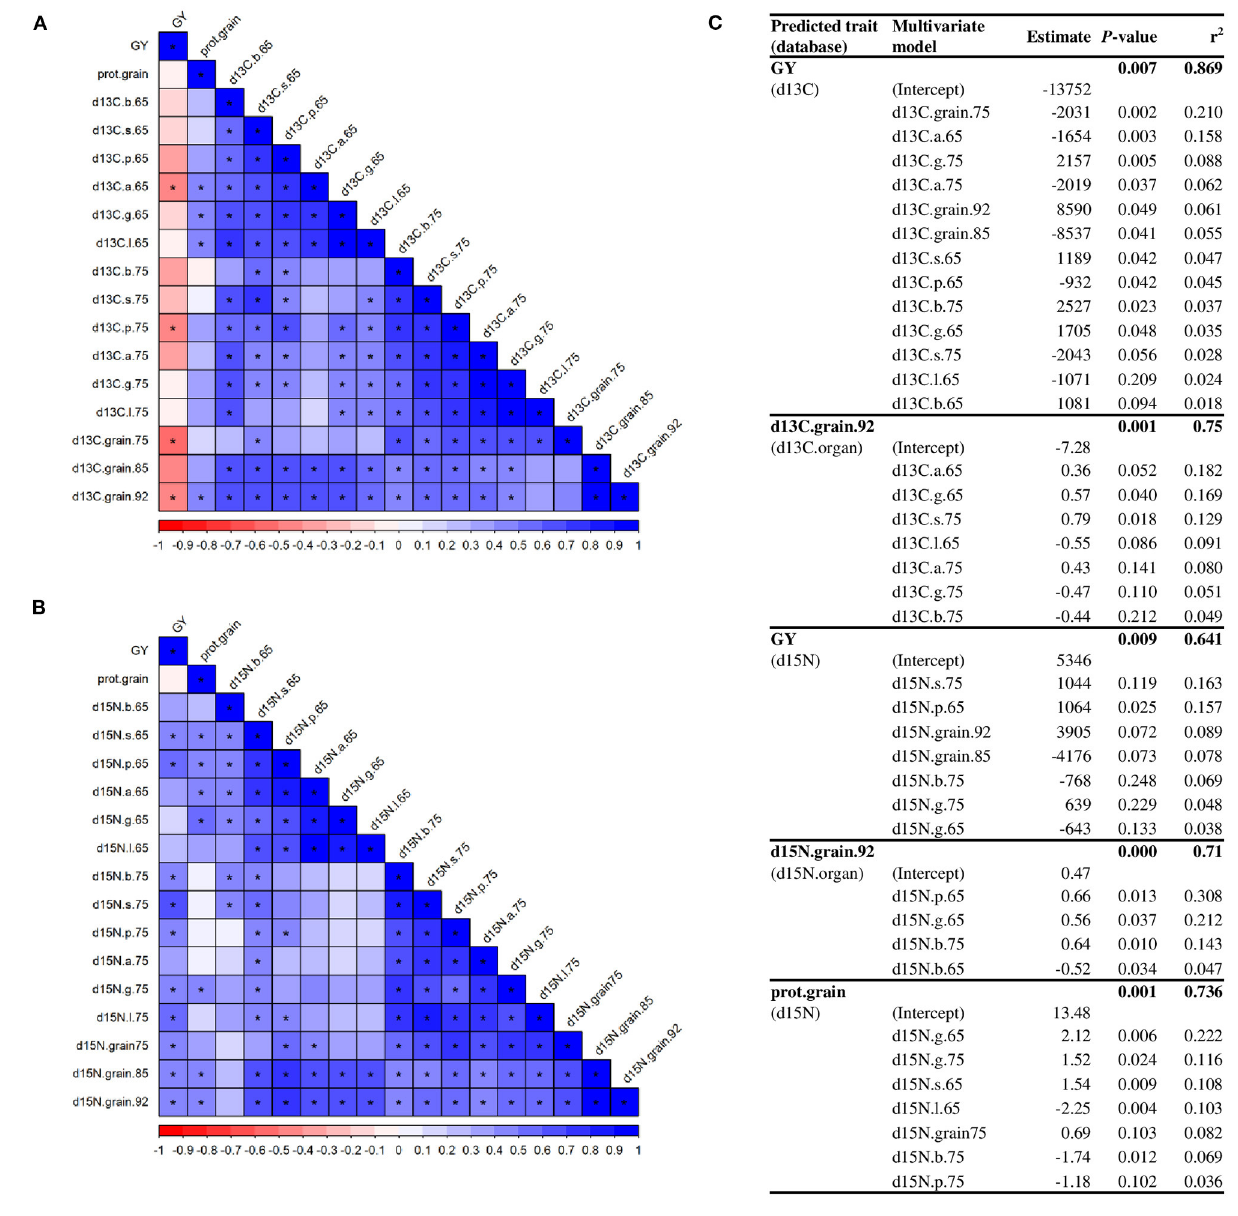
FIGURE 9 | The correlation matrix of C (A) and N (B) isotope composition per organ with grain yield and grain protein content. Asterisks indicate a significant correlation ( p < 0.05). Multivariate regression models (C) explaining grain yield and C and N isotope composition in grain at harvest across varieties under different N supplies. The abbreviations are described in Supplementary Table 1